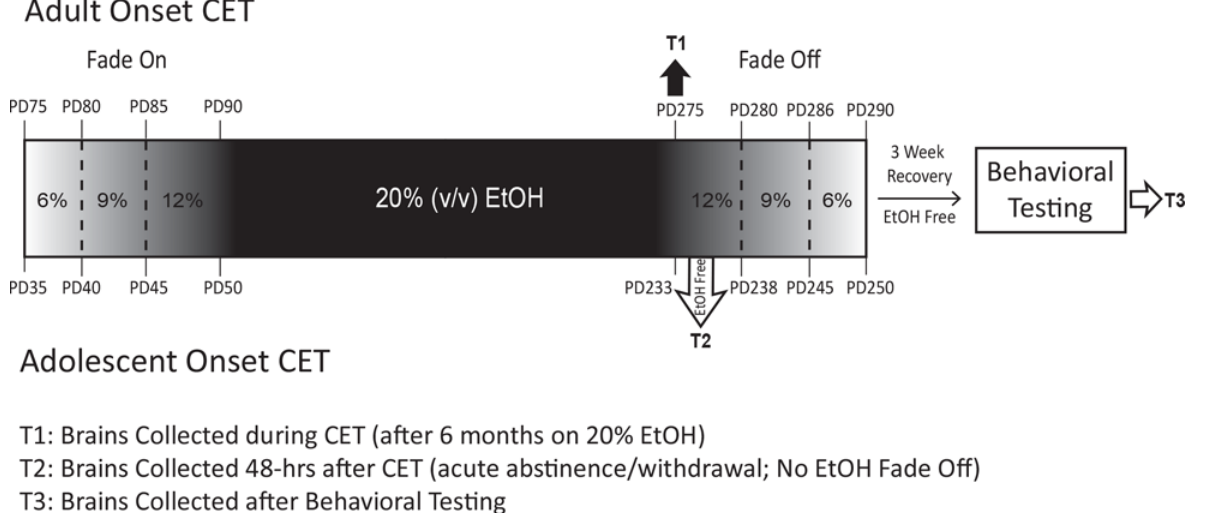
Fig 1. Chronic Ethanol Treatment (CET) Protocol Outline. Schematic illustrating the age range, ethanol (EtOH) exposure procedures, brain collection time points, and behavioral testing paradigms and for both adolescent onset and adult onset CET